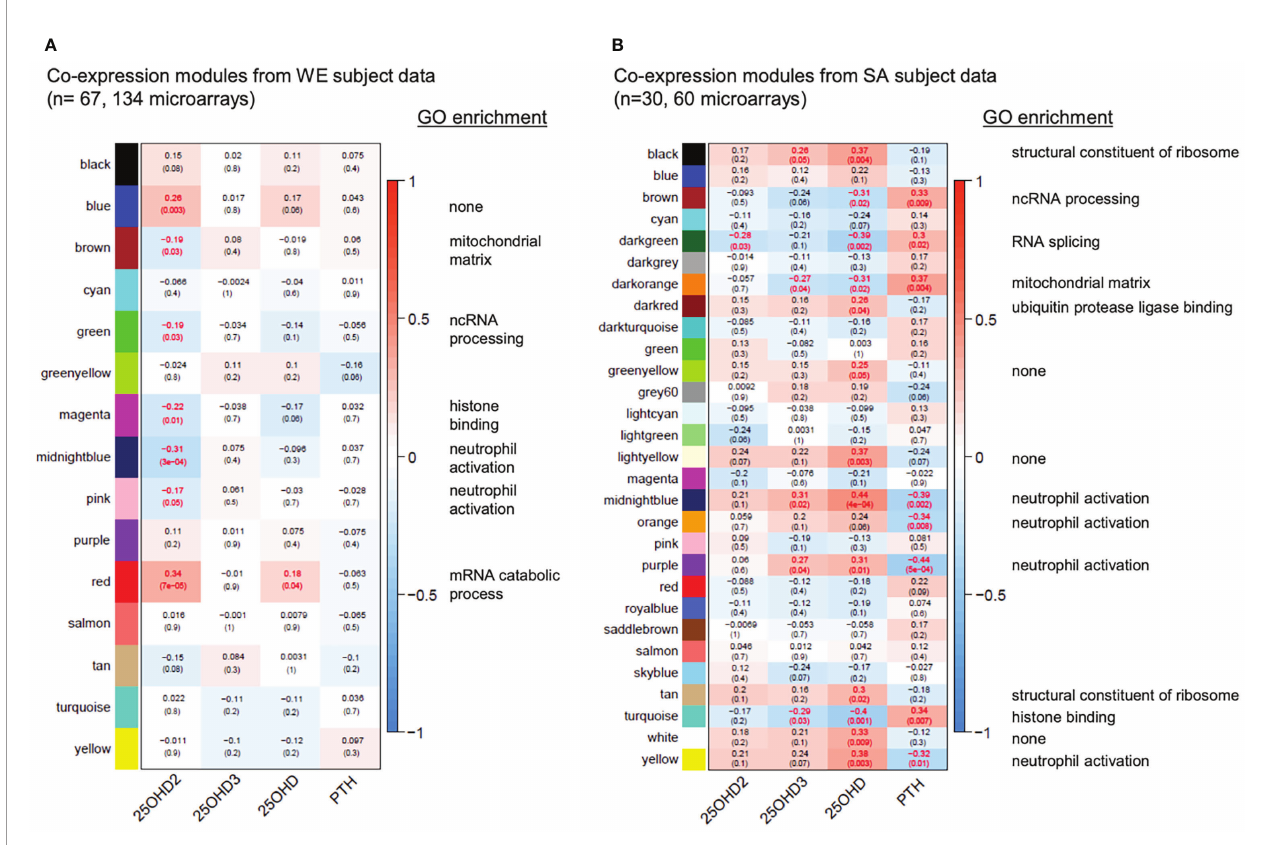
FIGURE 5 | Gene co-expression networks for the WE (A) and SA (B) ethnic groups. For each group of subjects, signed scale-free networks were constructed from the expression data using WGCNA to cluster probes with similar expression characteristics across all samples into discrete modules (colours on the y-axis: colours in (A, B) are independent). Module membership for the modules of genes identi fi ed in the WGCNA analysis of the data from the South Asian and white European cohorts are detailed in Supplementary Data File 6 . The colour scale to the right of each panel represents the Pearson correlation (from -1 to +1) between the expression pro fi le for each module ’ s eigengene and the respective serum 25(OH)D 2 , 25(OH)D 3 , total 25(OH)D and PTH concentrations (x-axis). The Pearson correlation coef fi cients are also provided in each box, followed in brackets by an adjusted p-value, testing for the signi fi cance of each correlation. Statistically signi fi cant correlations (adjusted p-value ≤ 0.05) are indicated in red. A headline signi fi cant GO functional enrichment category (p.adjust ≤ 0.01) for each signi fi cant module is shown to the right; GO test results for each module are summarised in Supplementary Data Files 7 , 8